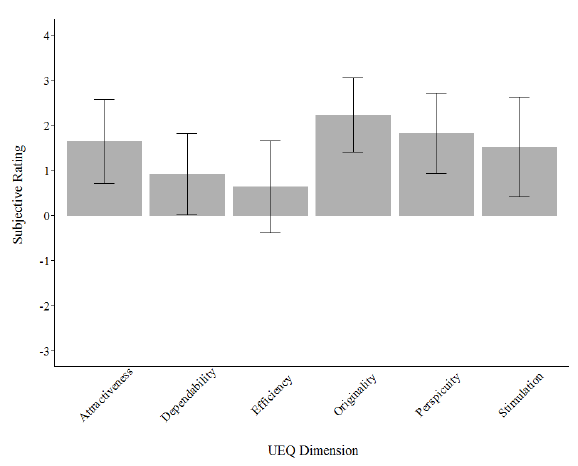
Figure 6. Mean UEQ results (-3 to 3 rating scale, error bars indicate standard